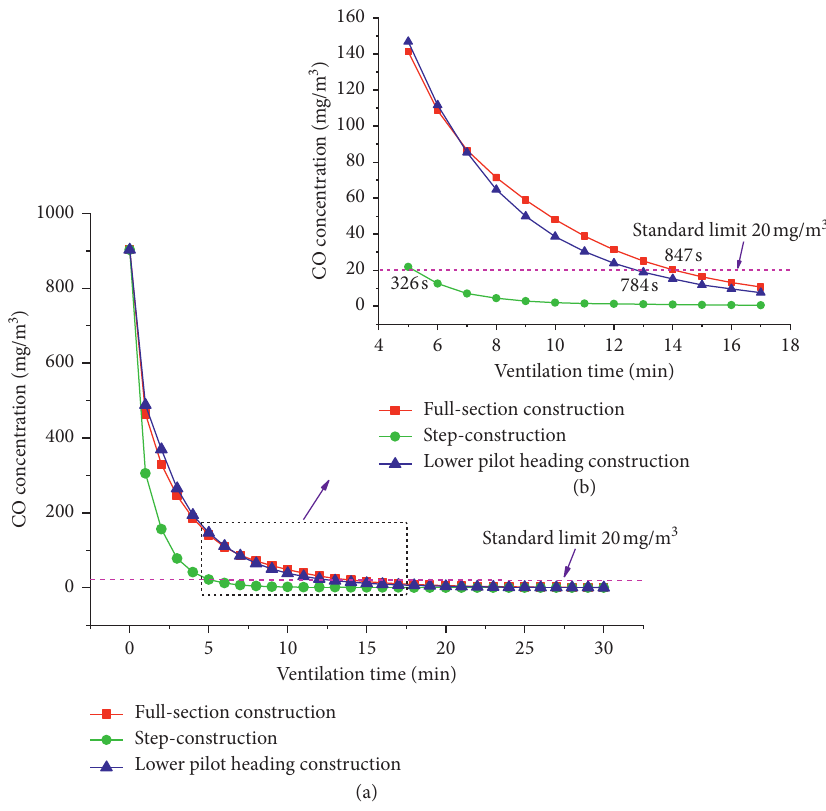
Figure 9: Variation curve of CO ventilation diffusion concentration at A of the tunnel face after